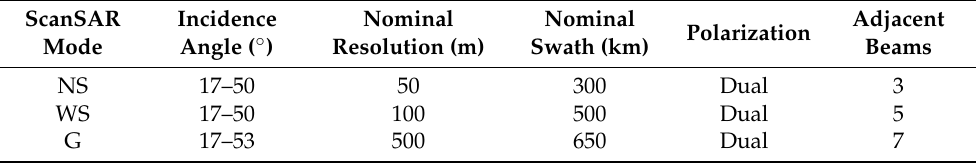
Table 1. ScanSAR modes of GF-3 satellite.